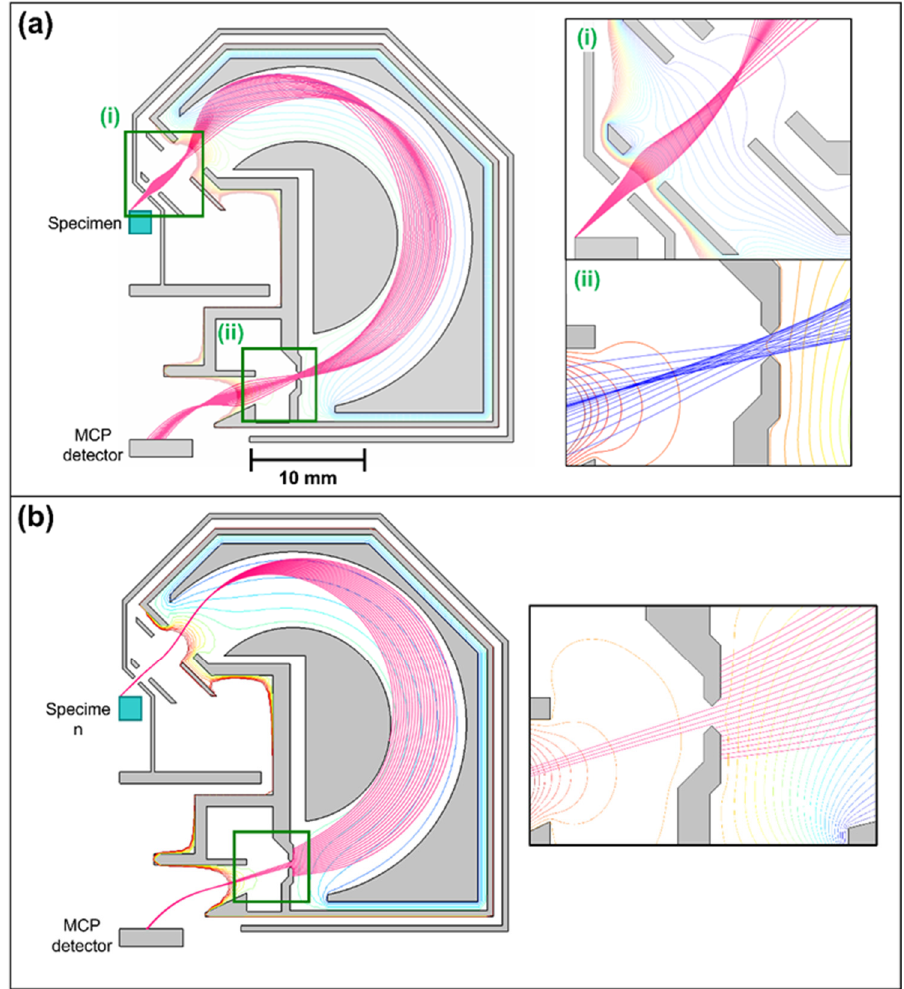
Figure 2. Direct ray tracing of BSEs in the optimized toroidal energy analyzer attachment design for a pass energy of 10 eV. ( a ) 1 keV BSEs emitted over a 40° to 50° polar angular range (i) Around the entrance region (ii) Around the exit region. ( b ) BSEs emitted in the 999 eV to 1001 eV energy range in 0.1 eV steps with a polar emission angle of 45°.